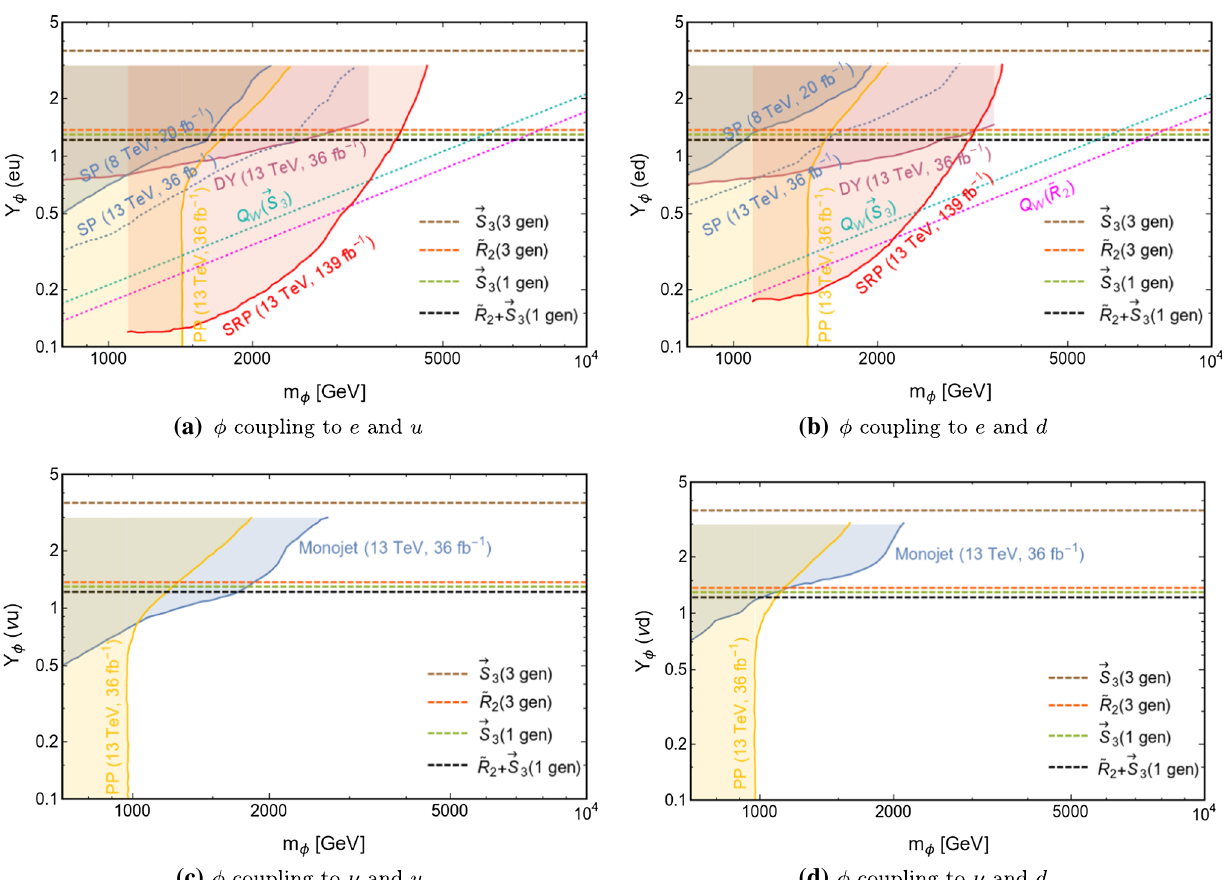
Fig. 19 Bounds on parameter space of scalar leptoquark coupling to first generation of quarks and leptons [156,157]. The shaded regions are disallowed by direct detection. The limits from pair production involv- ing charged leptons are recast from [158], while the same involving neutrinos are recast from [90]. These bounds are shown in yellow. The limits emerging from single production (SP), Drell–Yan (DY) and sin- gle resonant production (SRP), shown by bluish, maroonish purple and reddish portions, are based on Refs. [157,159,160]. On the other hand,